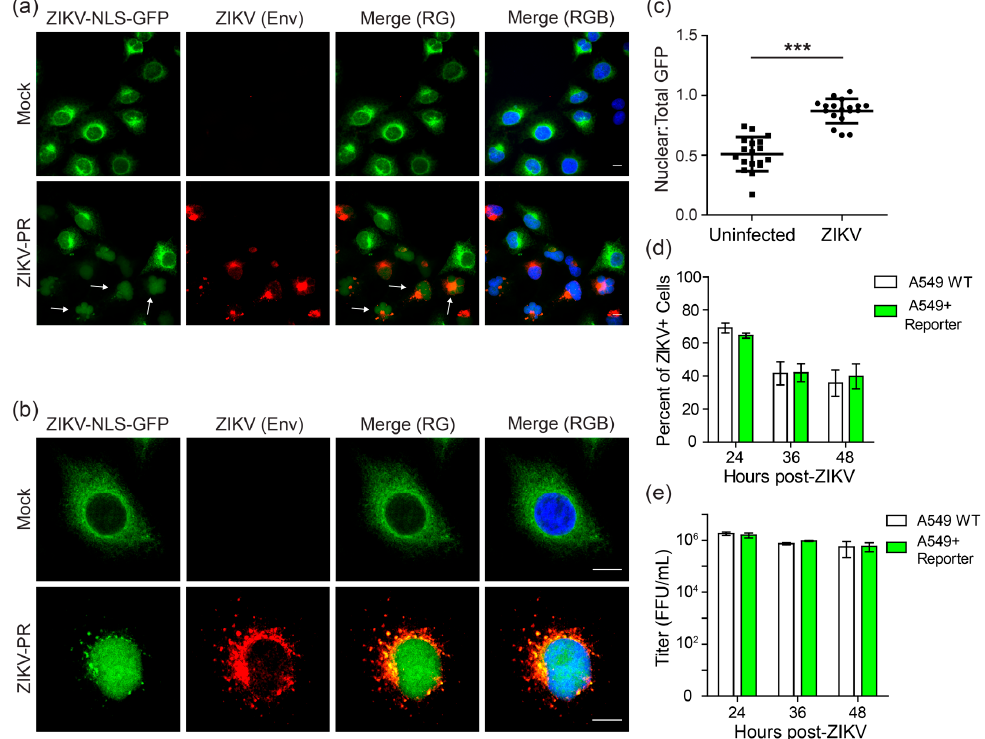
Figure 2. The cleavable ZIKV-NLS-GFP reporter can detect ZIKV infection. ( a , b ) Fluorescence ( a ), or confocal micrographs ( b ) of A549 cells stably expressing the ZIKV-NLS-GFP reporter (green) that were infected with ZIKV-PR (multiplicity of infection (MOI) 1) or mock for 48 h and then immunostained for ZIKV (anti-Envelope (Env); red). Nuclei were stained with DAPI (blue). Scale bar, 10 μ m. Arrowheads in the bottom panel of ( a ) indicate some representative cells staining positive for ZIKV with nuclear GFP localization. ( c ) The ratio of nuclear to total fluorescence intensity, as determined using Image J, in uninfected and ZIKV-infected cells from confocal micrographs of cells immunostained for ZIKV. Each dot represents an individual cell ( n = 18). Dot plots represent the mean ± SD. Asterisks denote significance; *** p < 0.0001, as determined by an unpaired t -test. ( d ) Fields were captured at various time points post-infection with ZIKV-PR (MOI 10) of A549 cells (WT or stably expressed ZIKV-NLS-GFP) immunostained for ZIKV Env and nuclei (DAPI), and the percentage of ZIKV+ cells was calculated. Values represent the mean ± standard error of the mean (SEM) ( n = 3 fields) from three independent experiments, with >3000 cells counted per field. ( e ) Supernatants from A549 cells (WT or stably expressed ZIKV-NLS-GFP) were harvested at 24, 36, and 48 h post-infection with ZIKV-PR (MOI 10) and viral titer was measured by focus forming assay. Values represent the mean ± standard deviation (SD) ( n = 3) from one experiment, representative of two independent